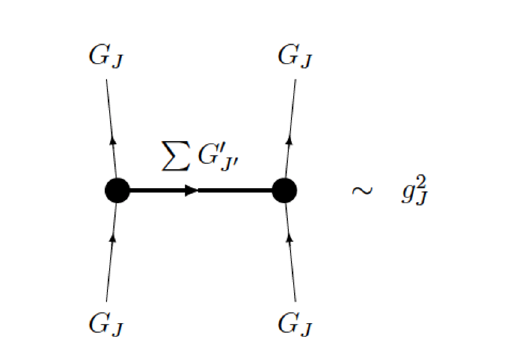
Figure 2 . A G J particle can interact with itself by exchanging one or multiple particles from the { G J } -sector. The strength of this interaction is controlled by the parameter g J